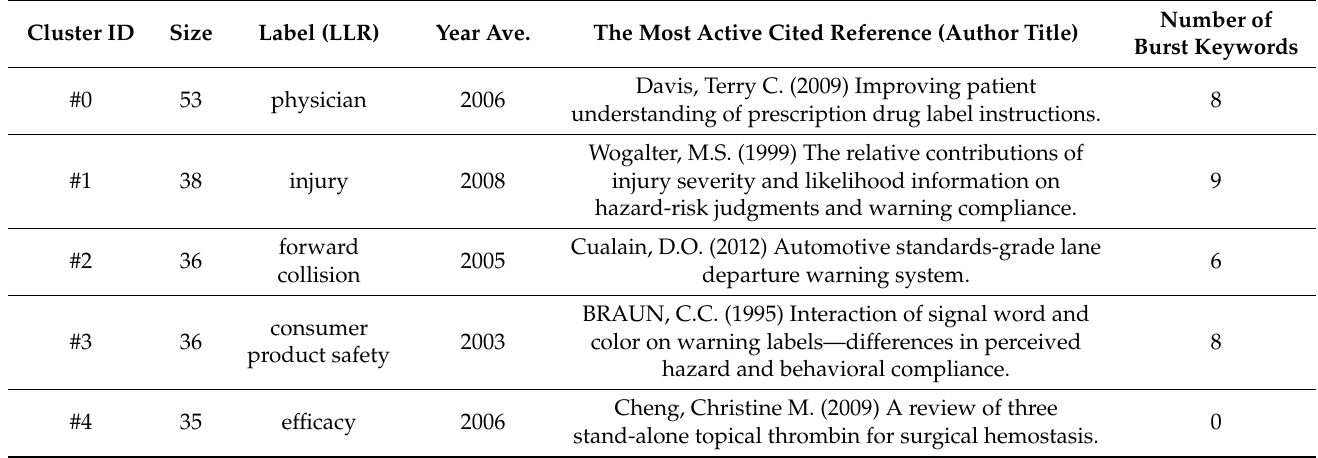
Figure 7. Keyword co-occurrence network. Table 5. Keyword co-occurrence clusters’ names and main cited